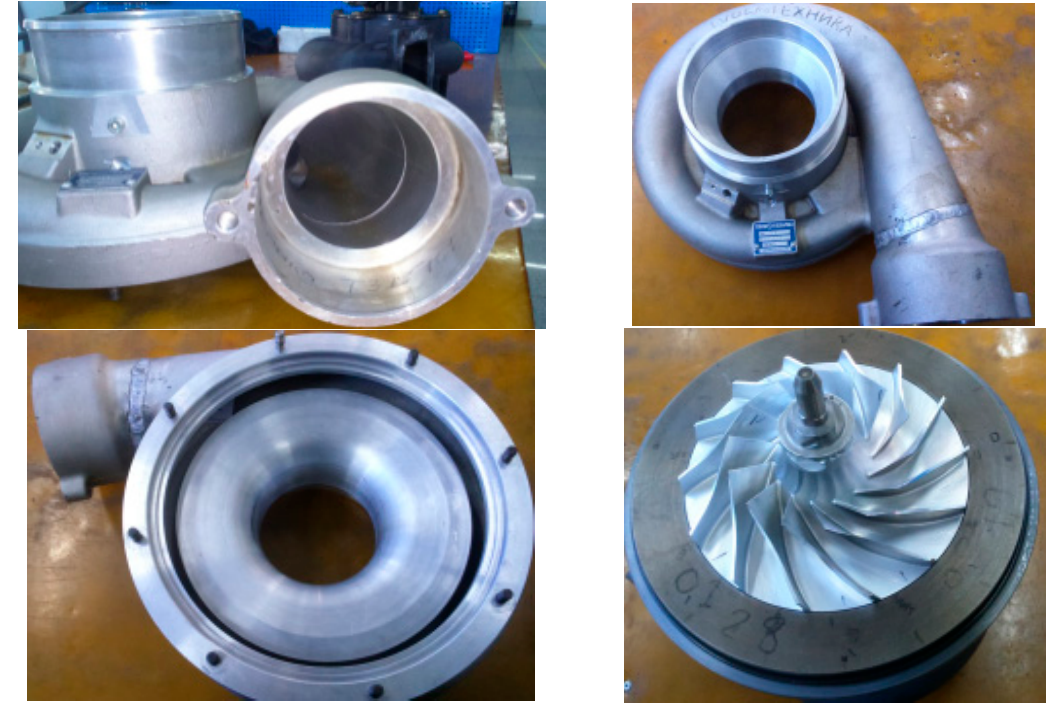
Figure 8. Compressor TKR-175E view.